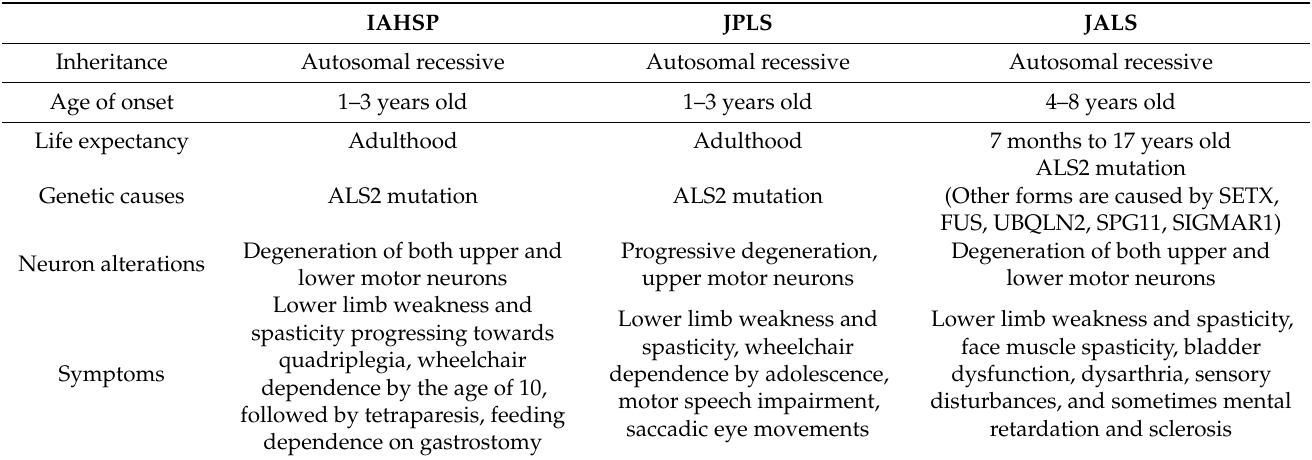
Table 1. Comparison of the main clinical features characterizing ALS2 gene mutation-related diseases, i.e., IAHSP, JPLS, and